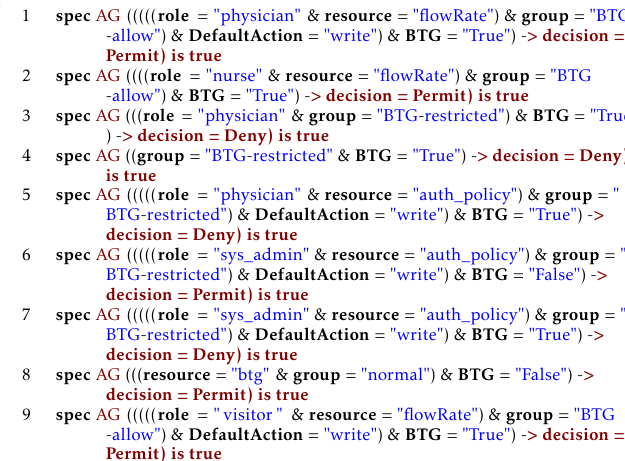
Figure 9. Results of ACPT verification of policy